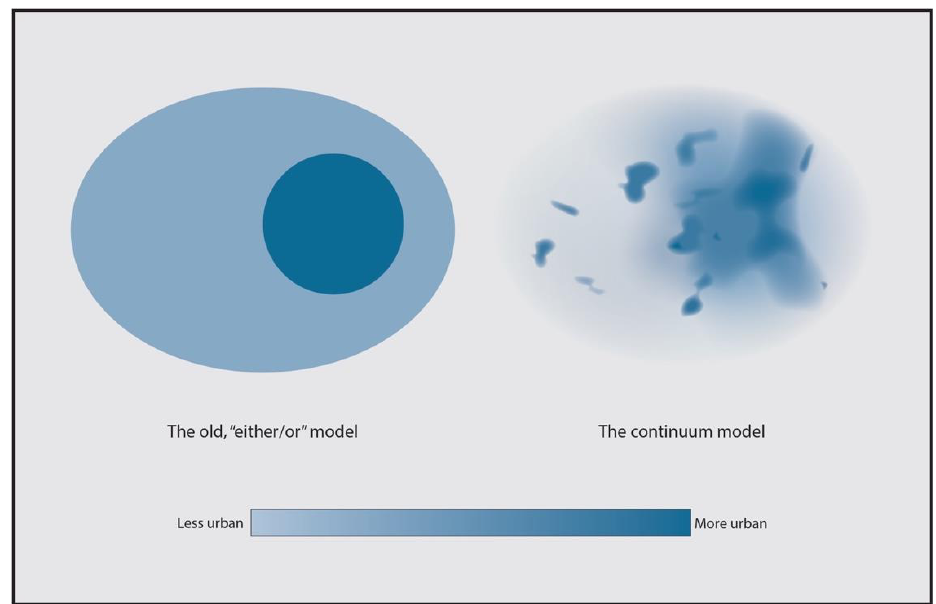
Figure 1. The challenges of defining and delineating “urban”, since it is a continuum (drawn by Jay Balagna after ref. [76]).